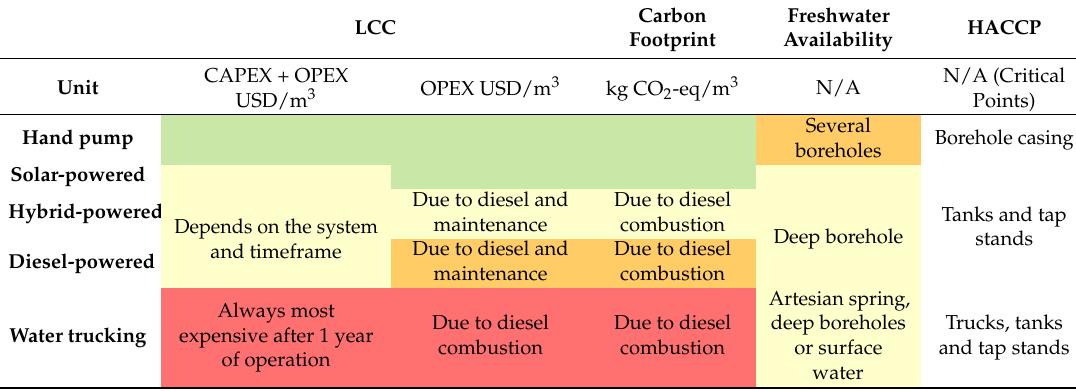
Table 5. Summary of results from the sustainability assessment. The colour code shows a qualitative ranking of the criteria, where green is the best and red is the